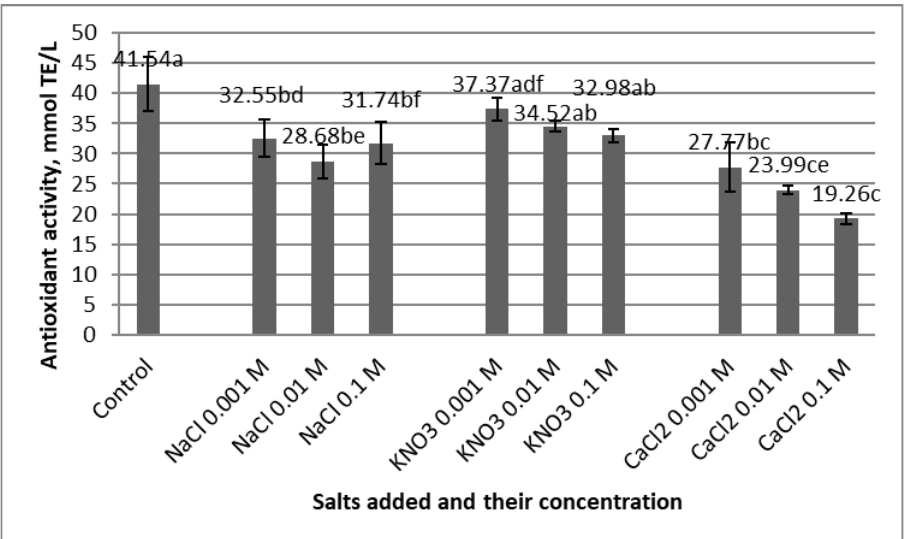
Figure 1. The antioxidant activity of rose hip ethanolic extract in the presence of different salts and different concentrations (standard deviations are based on three replicates; different letters (a–f) designate statistically different results ( p ≤ 0.05) ). Table 2. Change of CIELab color parameters for different salts and different concentrations (standard deviations are based on three replicates).